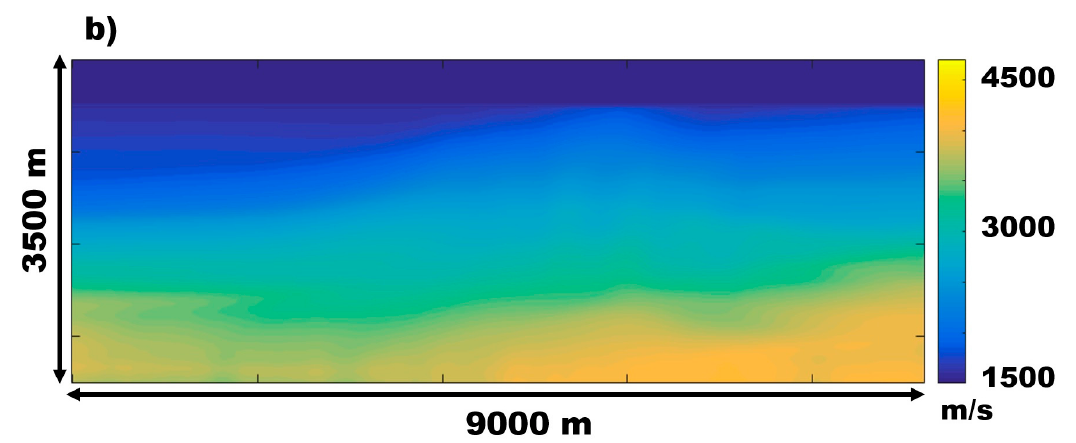
Figure 3. ( a ) The true distribution of velocities in the Marmousi model. ( b ) Initial velocity model for FWI.